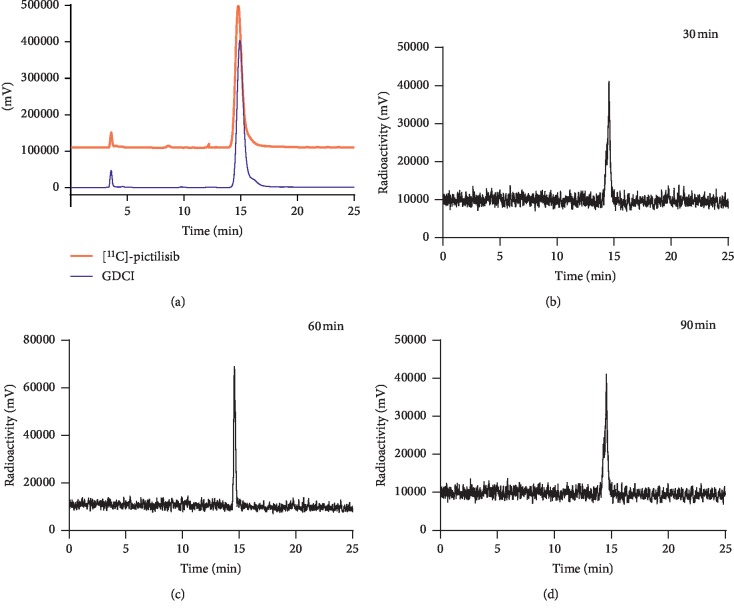
(a) Analytic HPLC chromatograms after the coinjection of [11C]-pictilisib (retention time = 14.05 min) and reference standard GDCI (UV 254 nm); (b)–(d) [11C]-pictilisib stability in human serum after incubation at 37°C for 30 min, 60 min, and 90 min, respectively.